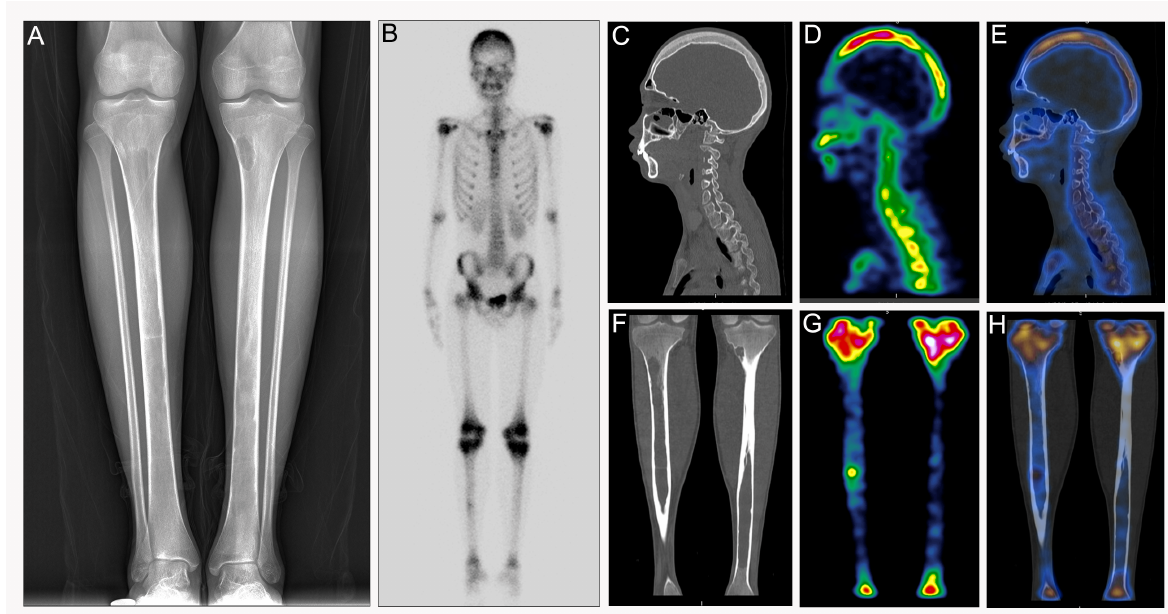
Figure 2. Patient 1: ( A ) Frontal radiograph of left tibiae demonstrated a well-demarcated lytic lesion that did not show sclerotic borders, endosteal erosion or associated expansion of the tibia shaft. ( B ) 99m Tc-MDP bone scan showed abnormal concentration of tracer around the knee joints, in the kull and bilateral humeral heads. ( C – E ) CT, SPECT and fusion images of the head. ( F – H ) CT, SPECT and fusion images of the both